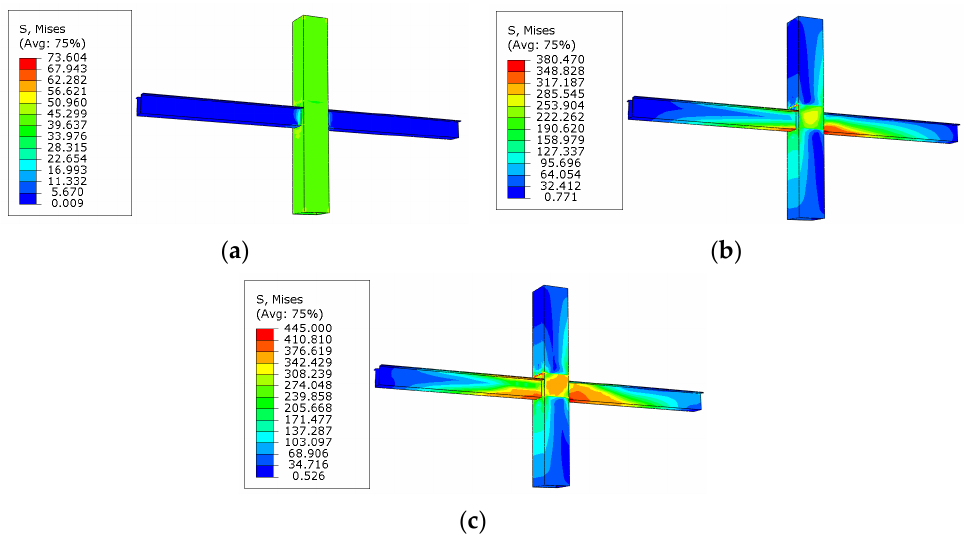
Figure 18. Development of von Mises stress of steel components: ( a ) von Mises stress contours of steel components subjected to axial load on the column; ( b ) von Mises stress contours of steel components at the yield state; ( c ) von Mises stress contours of steel components at the ultimate state. When there is only the axial load imposed on the ends of the column, the stress is small and uniform in most regions of the steel tube, and the initial stress appears in the steel beam adjacent to the steel tube. The maximum stress is located in the region near the junction between the tensile bottom plate of the steel beam and the column after the ver- tical loads are applied at the beam ends. Consequently, the stress in this region reaches the yield strength of steel with the increase of the vertical loads. As the specimen is at the ultimate state, the stress in the bottom plate of the U-shaped steel beam near the connec- tion zone has significantly exceeded the yield strength, especially for the tensile plate. However, the stress in the components that are far away from the connection zone is much smaller than the yield strength of the corresponding material. 6. Parametric Analysis On the basis of the RS connection, parametric studies are conducted to investigate the influences of some parameters on the behavior of the connection between CFUS beams and CFSST columns. These parameters include: The thickness of the U-shaped steel, the ratio of the longitudinal rebar in the concrete slab, the strength of the concrete in the beam, the strength of the U-shaped steel, and the thickness of the internal diaphragm. All the specimens are designed to satisfy the seismic principle of ‘strong column–weak beam and strong connection–weak members’. This is accomplished by limiting the beam-to-column linear stiffness ratio to less than 0.6, and the beam-to-column flexural capacity ratio to no more than 0.8 [24,25], resulting in failing at the beam ends for the connections. 6.1. Effects of Thickness of U-Shaped Steel The comparison of load-displacement curves with different thicknesses of the U- shaped steel are shown in Figure 19. It can be seen that the loading capacity of the con- nection increases obviously with the increases in the thickness of the U-shaped steel under both positive and negative P, and that the increase of the loading capacity under positive P is bigger than that under negative P. In addition, the increased amplitude of loading